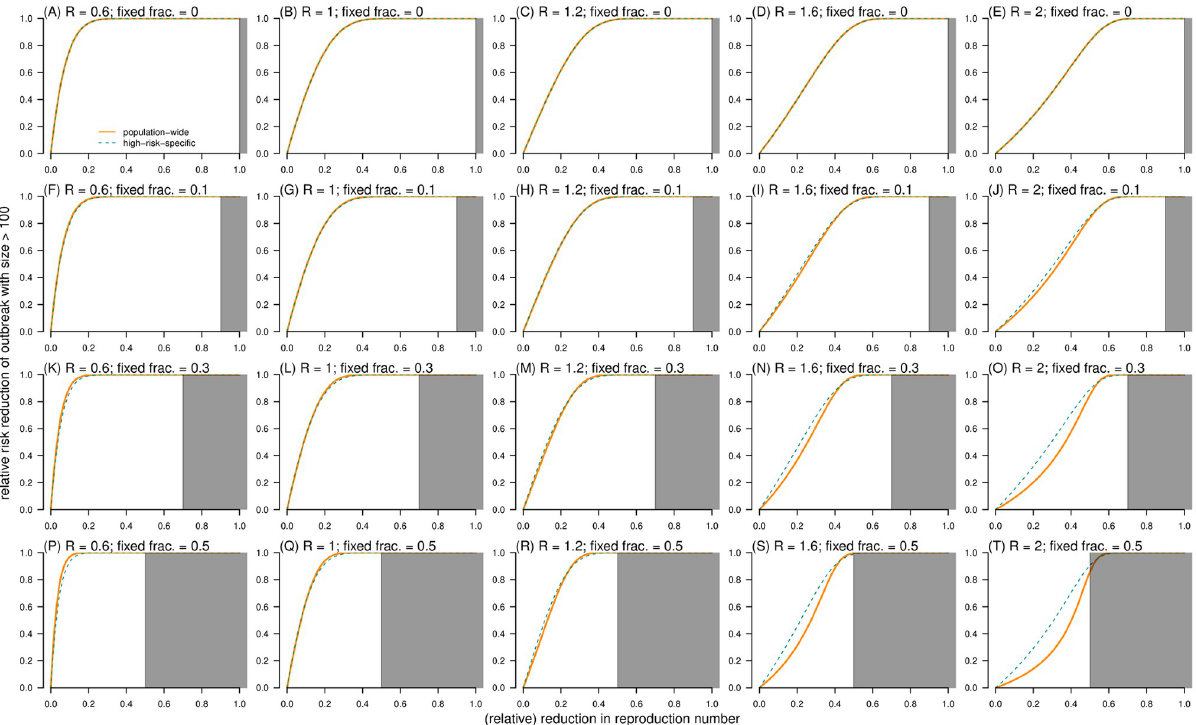
Fig 9. The relative risk reduction (RRR) of outcome (II): Having outbreak with final size c > 100 as a function of the relative reduction in reproduction number ( ξ ). The RRR of control scheme ( I ) RRR (1) ( ξ ) is dashed cyan curve, and the RRR of control scheme ( II ) RRR (2) ( ξ ) is bold orange curve. In each panel, the dispersion parameter k is fixed at 0.2, and the shading region indicates the situation that ξ � 1 − ρ . In each panel label, ‘ R ’ is the reproduction number, and ‘fixed frac.’ is the fraction of fixed component ( ρ ).